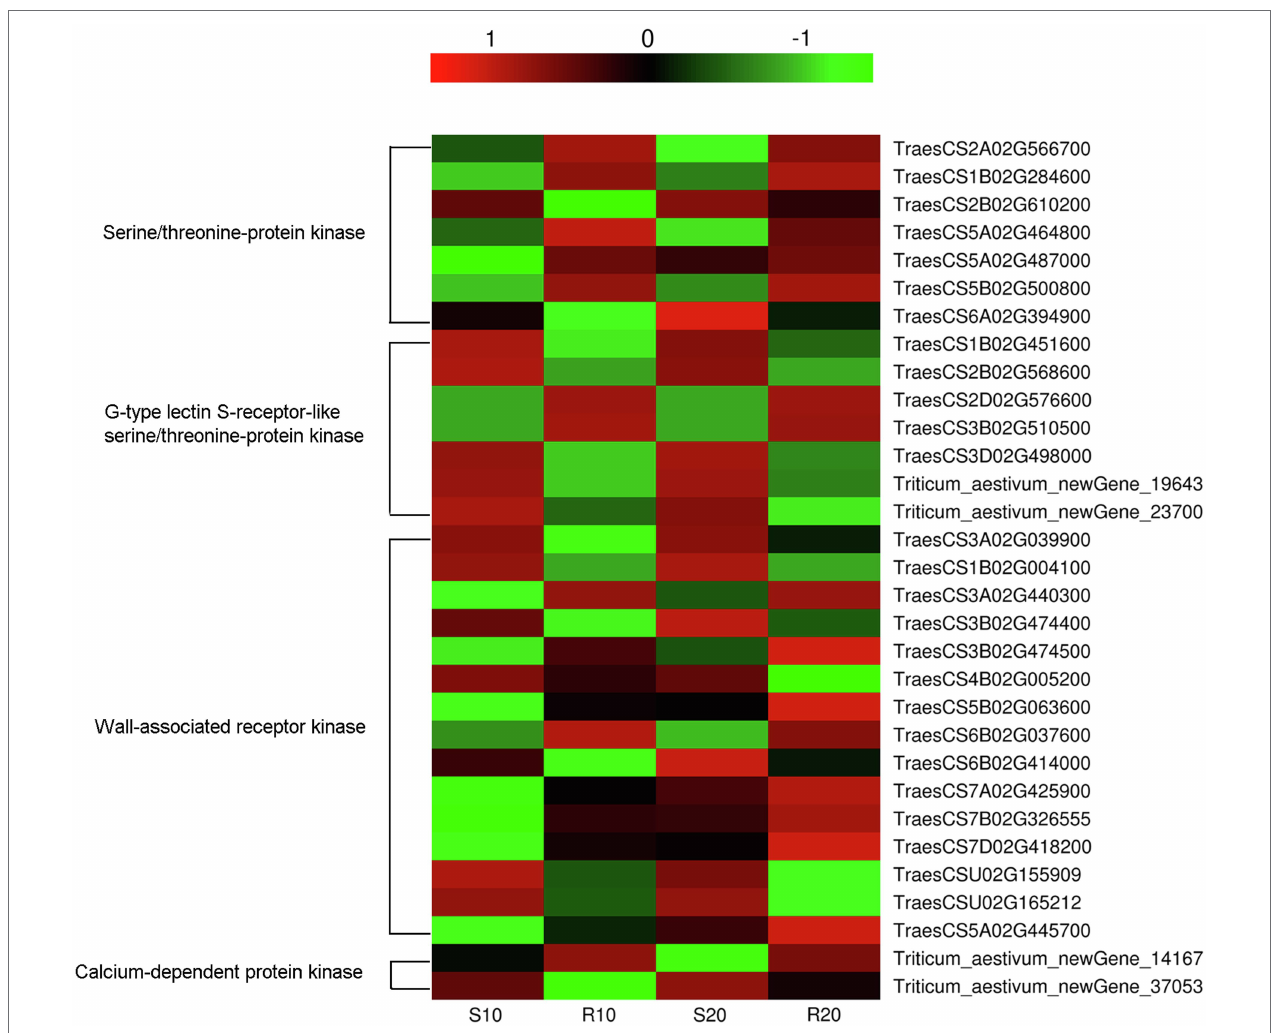
FIGURE 8 | Heatmap of transcript levels of disease-resistance kinases related to Pst resistance in leaves of resistant and susceptible triticale cultivars 10 and 20 days after Pst